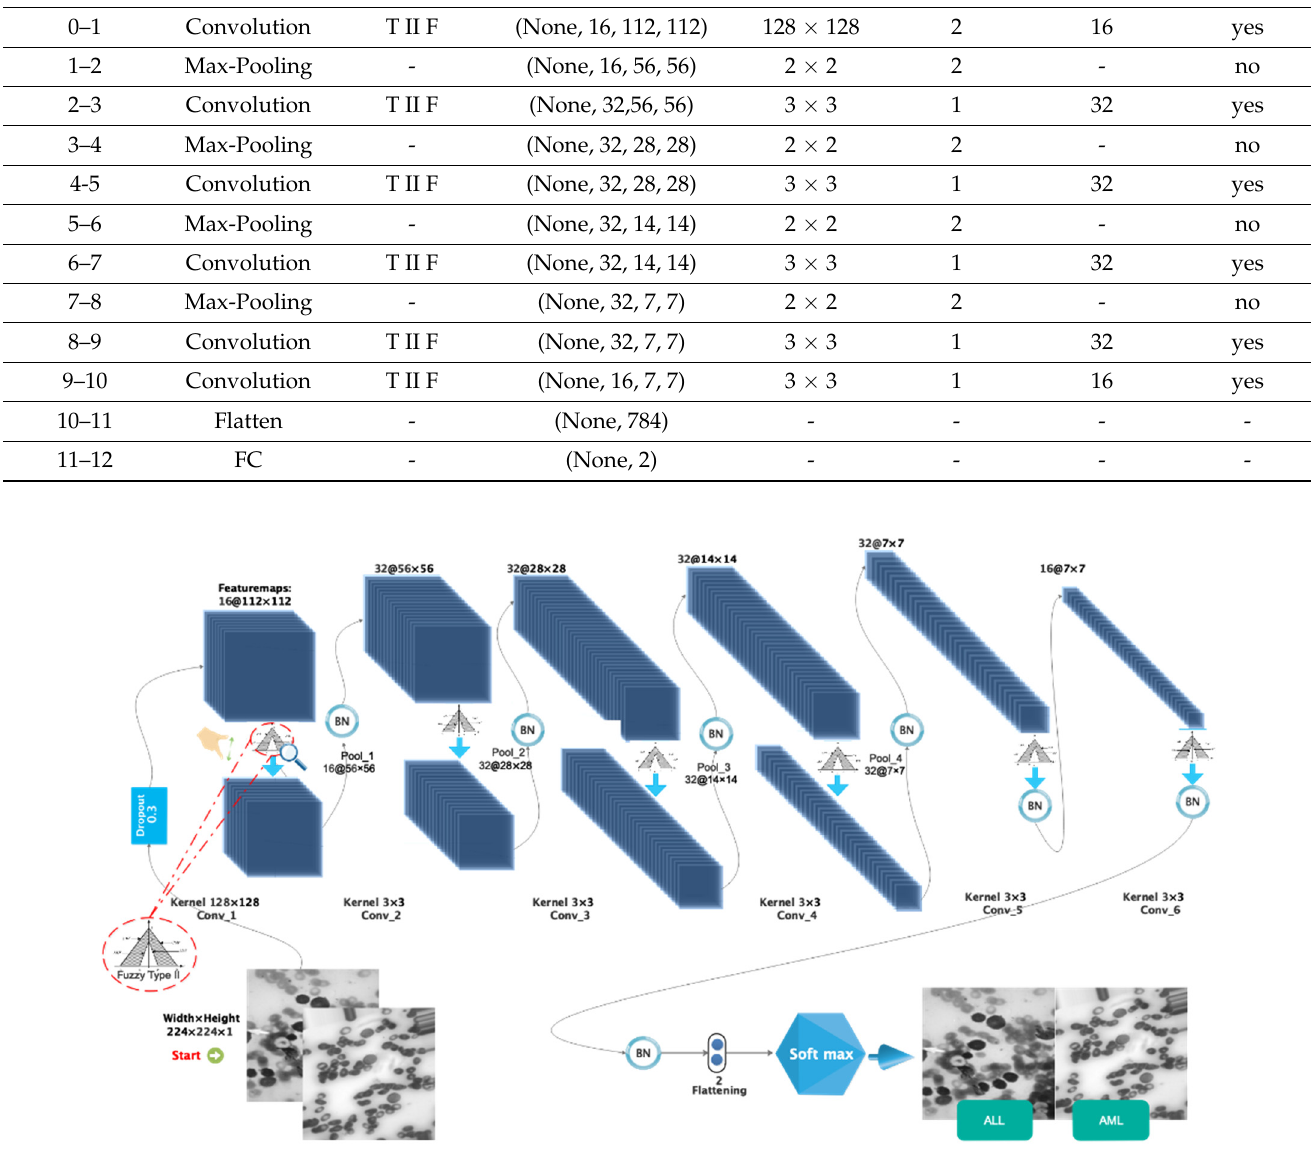
Table 1. Details of the layers in the construction of the proposed network.